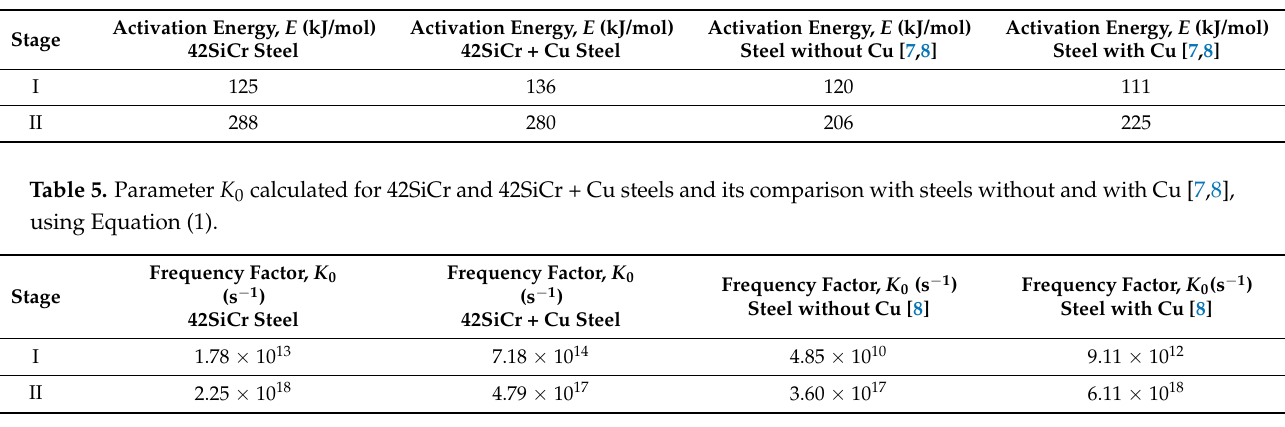
Figure 12. The temperature range for the formation of cementite in 42SiCr and 42SiCr + Cu steel tempered using heating rate β = 0.003 K/s. Table 4. Activation energy E calculated for 42SiCr and 42SiCr + Cu steels and its comparison with steels without and with Cu [7,8], using Equation (1).